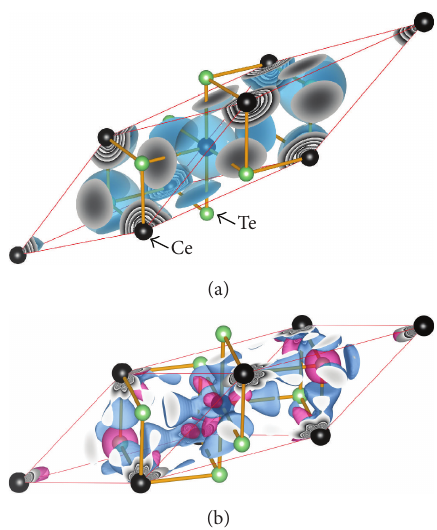
Figure 3: Total (a) and bonding charge (b) density of CeTe in the spin-polarized rhombohedral structure. In (a) the blue surface indicates 0.005 electron/ 𝑎𝑢 3 level of density and grey regions indicate intersection between the constant density surface with the primitive unit cell surface. Blue (red) surface indicates +0.003 ( − 0.003) electron/ 𝑎𝑢 3 density difference between CeTe and sum of separate Ce and Te atoms in the same structure in (b).